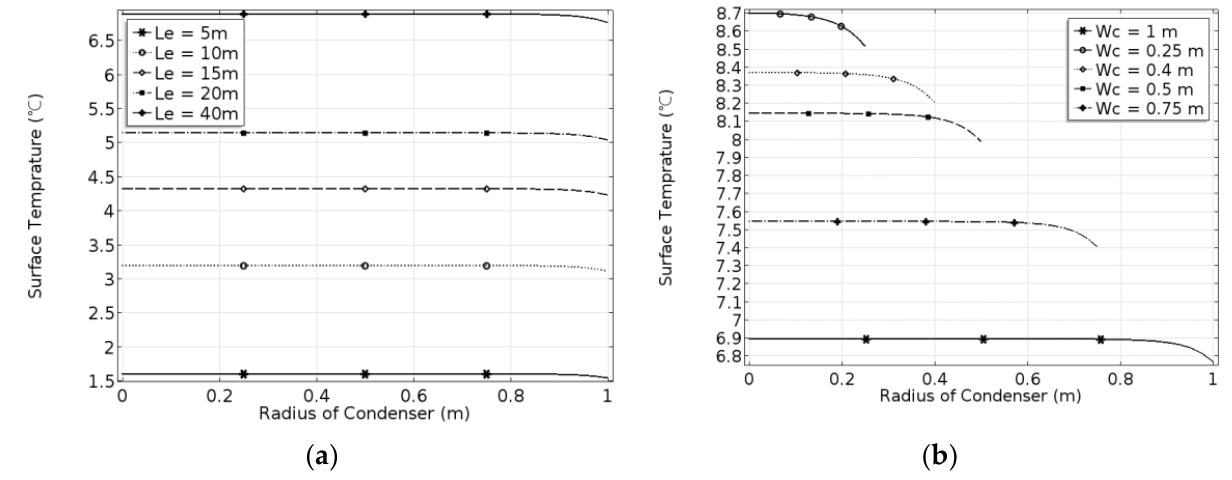
Figure 8. Surface temperature at various ( a ) Le values and ( b ) Wc values.